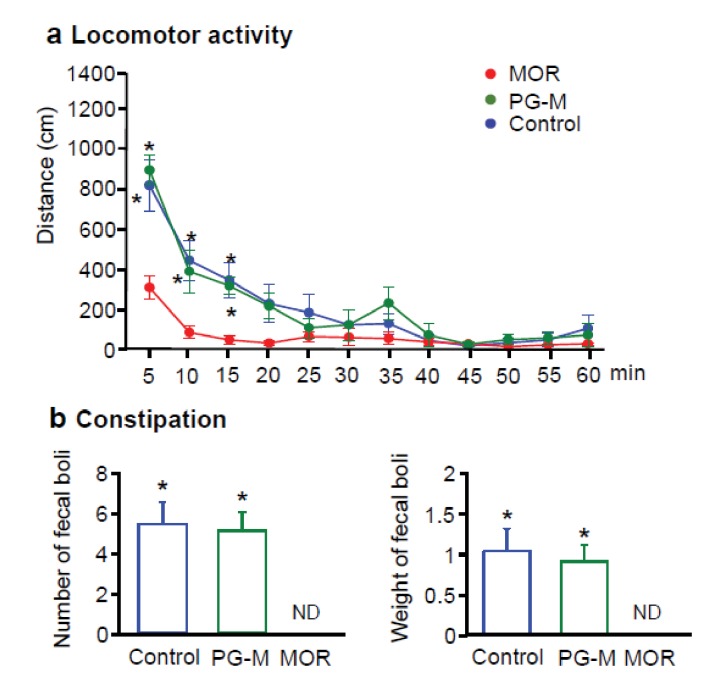
Effects of intravenous (i.v.) morphine or PG-M on locomotor activity and defecation in rats with unilateral hindpaw inflammation.(a) Locomotor activity after i.v. injections of morphine (MOR), PG-M or 0.9% NaCl. *p<0.05, two-way RM-ANOVA and Bonferroni test (compared to MOR); N = 8 rats per group; means ± SEM. (b) Number (left) and total weight (right) of fecal boli produced after i.v. injections of MOR, PG-M or 0.9% NaCl. Dosages of MOR and PG-M represent the same absolute amounts of morphine-free base (12 mg/kg; see Table 1). ND: none detected; *p<0.05, one-way ANOVA and Bonferroni test (compared to MOR); N = 8 rats per group; means ± SEM.DOI:
http://dx.doi.org/10.7554/eLife.27081.01410.7554/eLife.27081.015Figure 8—source data 1.Raw data for Figure 8.